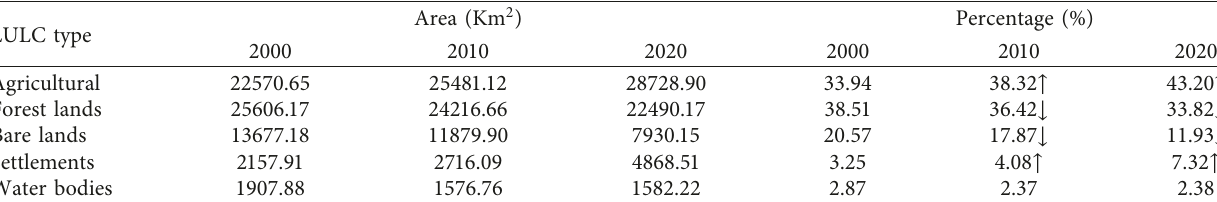
Figure 4: Land use and land cover over the years. (a) For 2000. (b) For 2010. (c) For 2020. Table 4: Land use and land cover change statistics of Sri